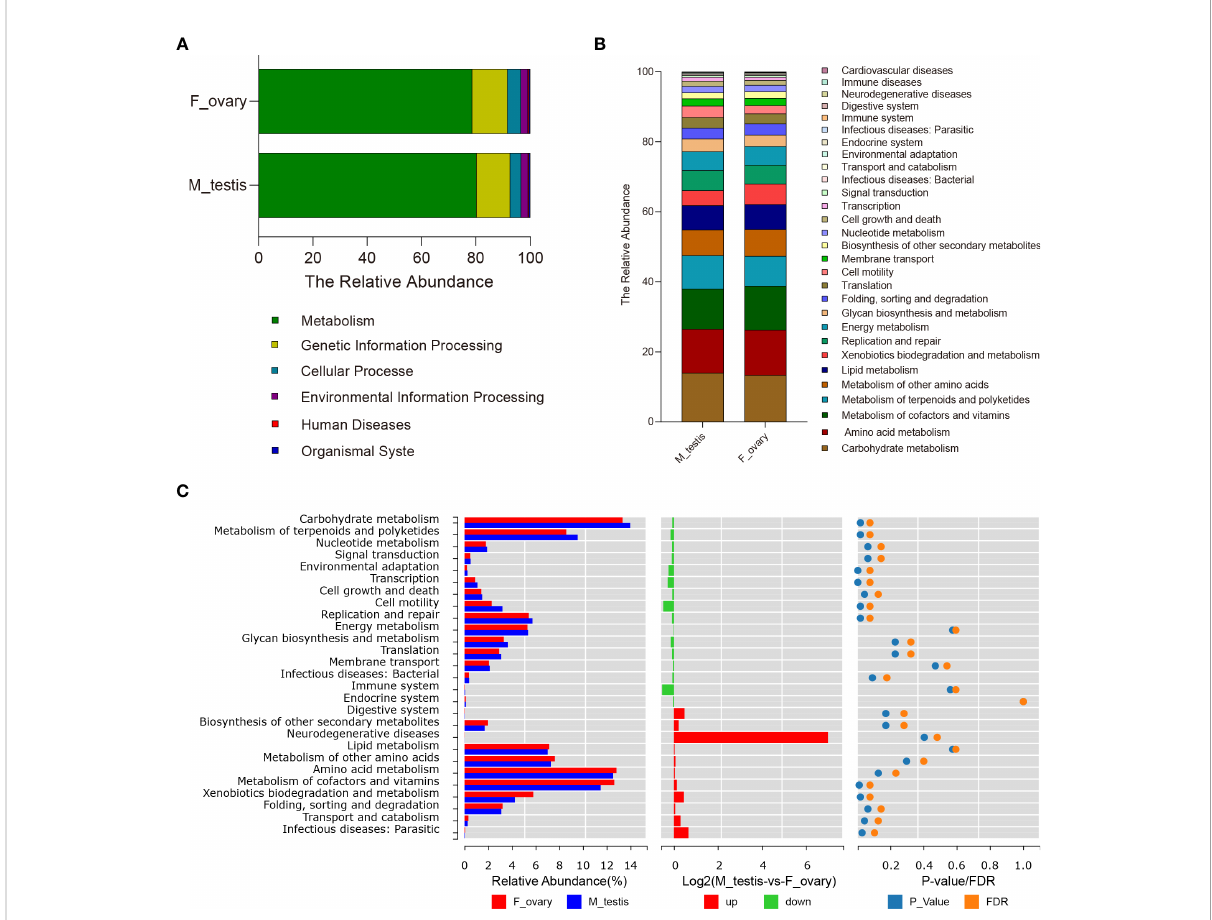
FIGURE 6 Predictive analysis of microbiota function in gonads of the M. albus . (A) Average relative abundances in predicted functional genes of gonadal bacterial community at KEGG level 1. (B) Average relative abundances in predicted functional genes of gonadal bacterial community at KEGG level 2. (C) Average relative abundances and differences in predicted functional genes of gonadal bacterial community at KEGG level